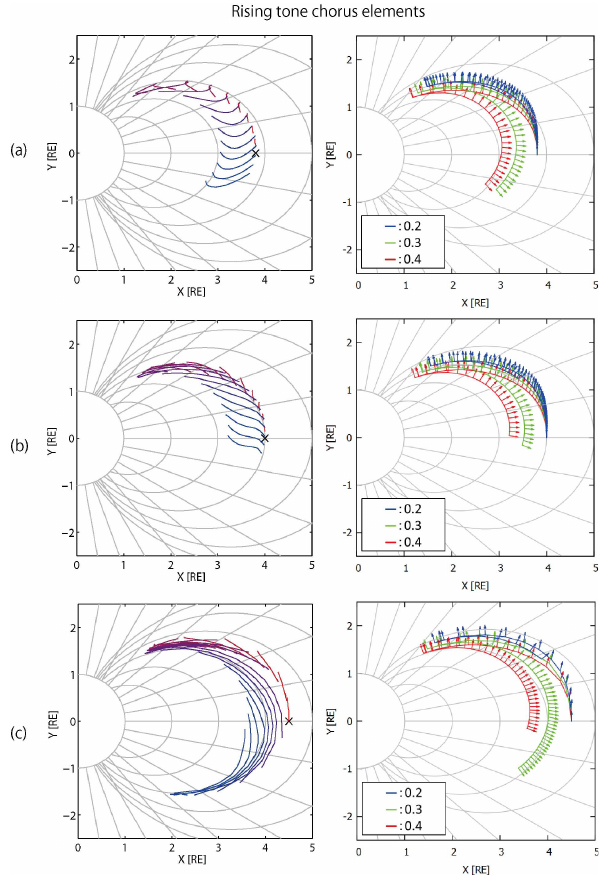
Fig. 2. Ray tracing of rising tone chorus elements with frequency span f = 0 . 2–0.40 (cid:127) e / 2 π (Hz), pulse length 50ms. Start points are with zero propagation angle at the equator and at (a) L = 3 . 8 (b) L = 4 . 0 and (c) L = 4 . 5. Left-hand panels show the physical extent and orientation in 2-D space of each rising frequency element as time progresses. The right-hand panels ray trace three rays at frequencies f = 0 . 2, 0.3, 0.4 (cid:127) e / 2 π (Hz) and show evolution of the k vector orientation with respect to B 0